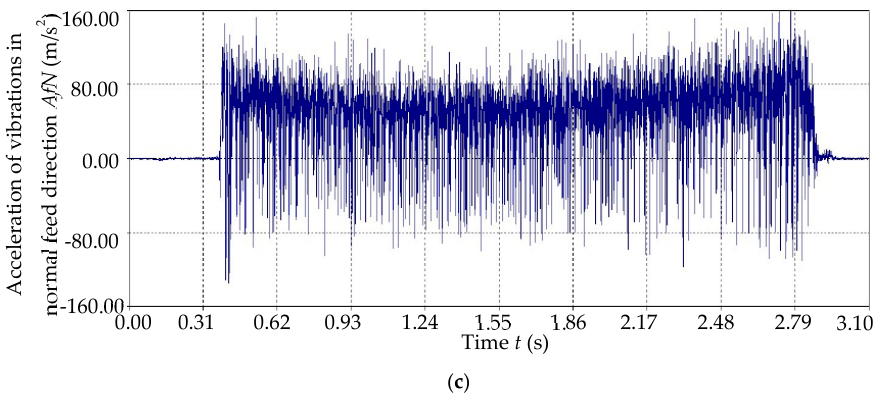
= 300 m / min, ( b ) v c